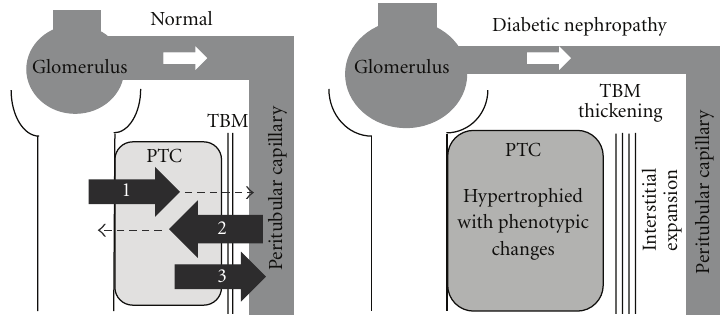
Figure 1: Normal functions of proximal tubule cells (PTCs) and structural changes around the cells in the early stages of diabetic nephropathy. Normal functions of PTCs include (1) reabsorption and intracellular processing of glomerular-filtered substances via apical membrane receptors, transporters, and channels; (2) uptake of substances via basolateral membrane transporters followed by metabolism or secretion into the urinary space; (3) synthesis of bioactive substances that are released to peritubular capillaries. These functions are impaired in diabetic nephropathy even at the early stages in which PTCs are hypertrophied with increased metabolic demands and are phenotypically altered. In addition, tubular basement membranes (TBMs) are thickened, and interstitial spaces are expanded with fibrosis, alienating PTCs from interacting with peritubular